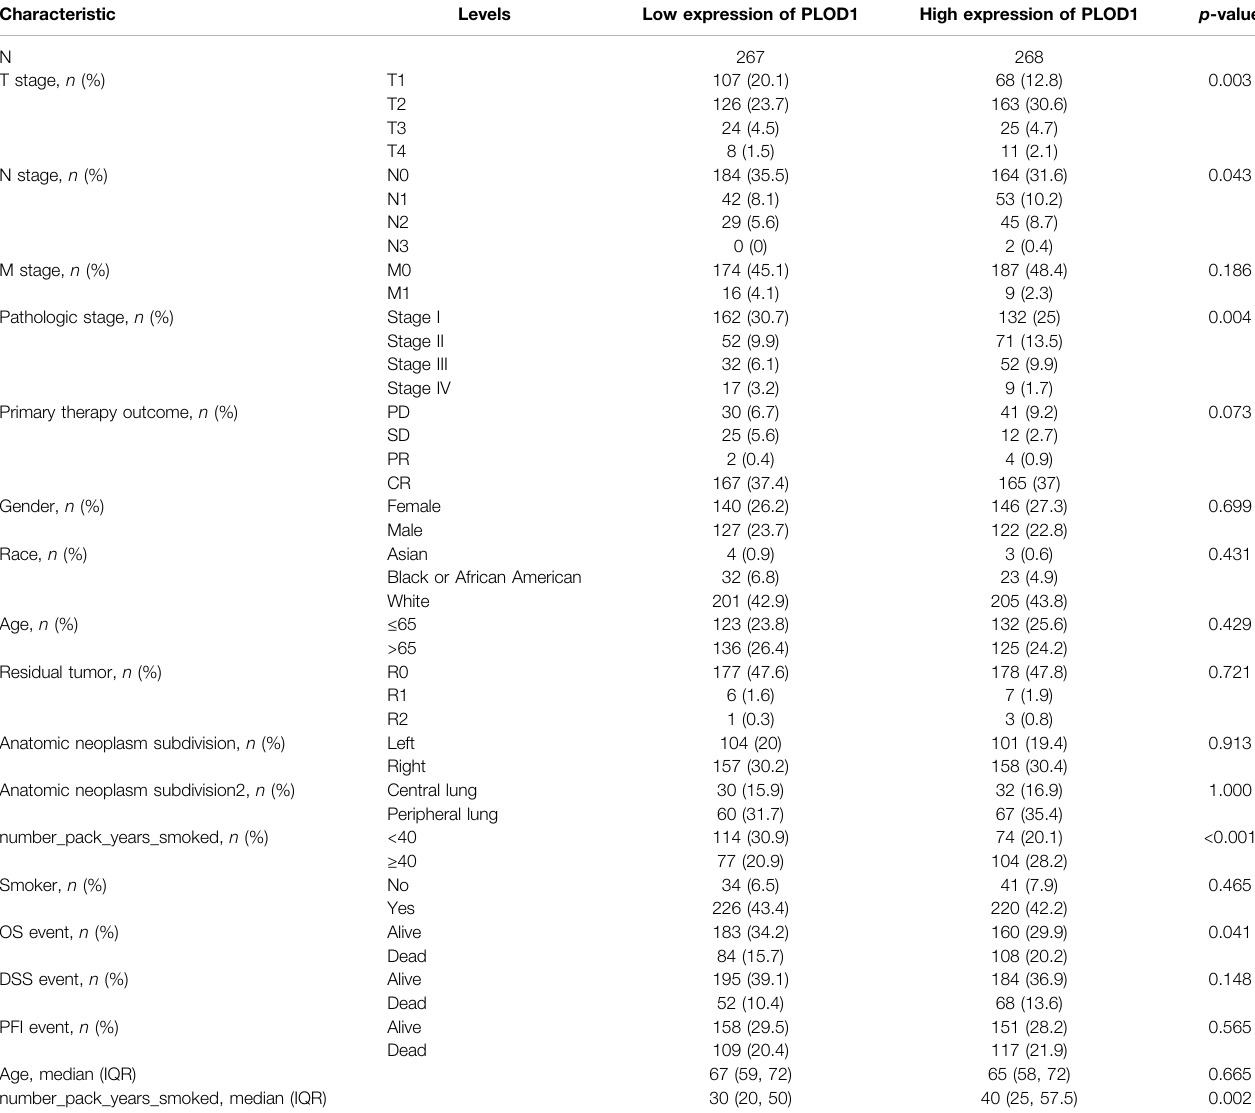
TABLE 1 | Clinical Characteristics of the LUAD patients (TCGA) Characteristic Levels Low expression of PLOD1 High expression of